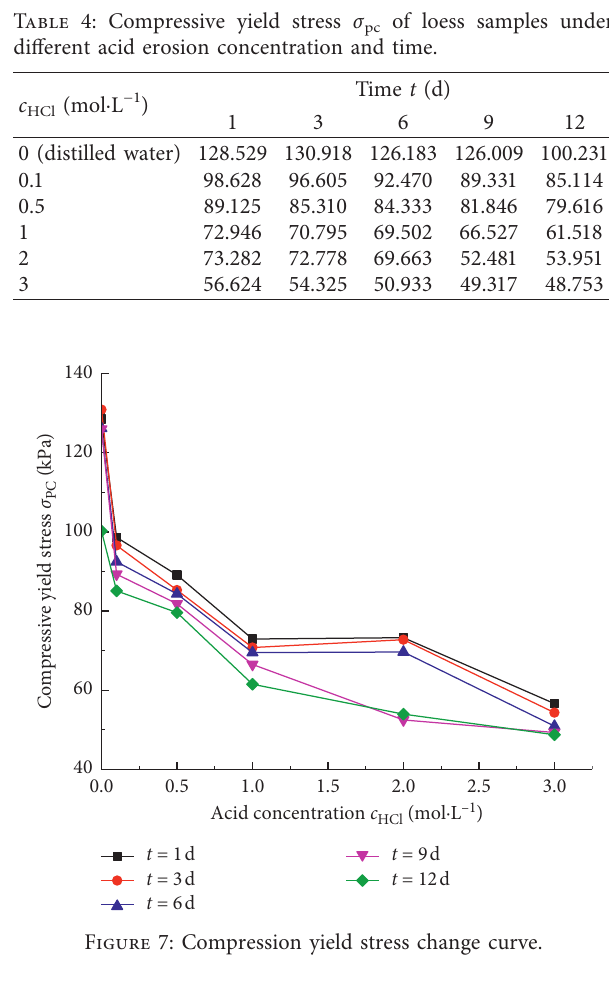
pc of loess samples under